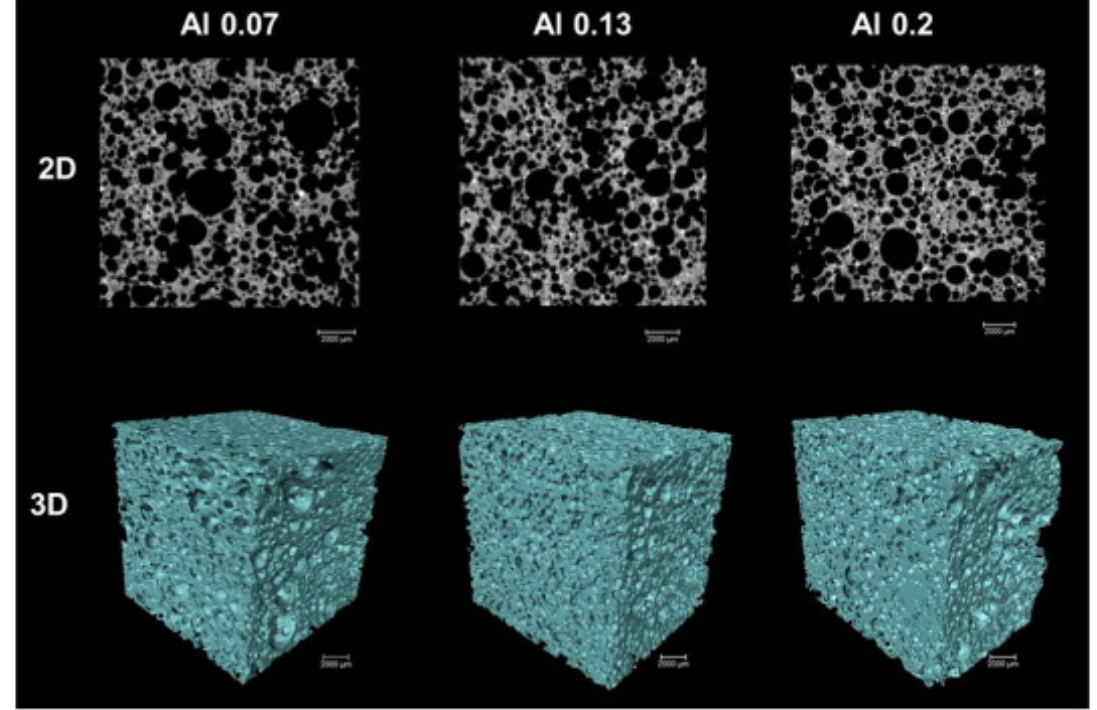
Figure 8. Micro-tomography images of geopolymer foams produced with Al powder as a foaming agent. Reprinted from Reference [81], © 2020, with permission from Elsevier.